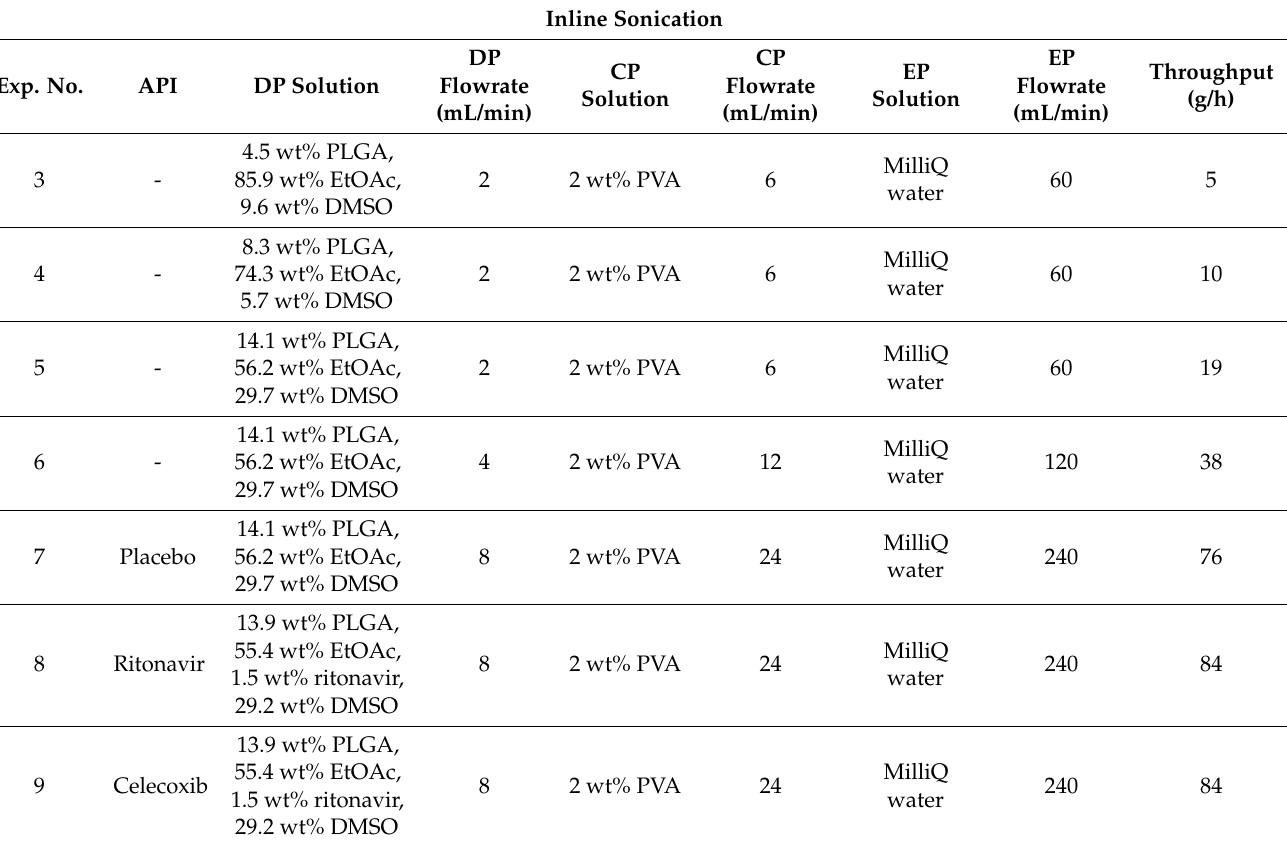
Table 3. Process parameters evaluated for the inline sonication method scale-up. Inline Sonication